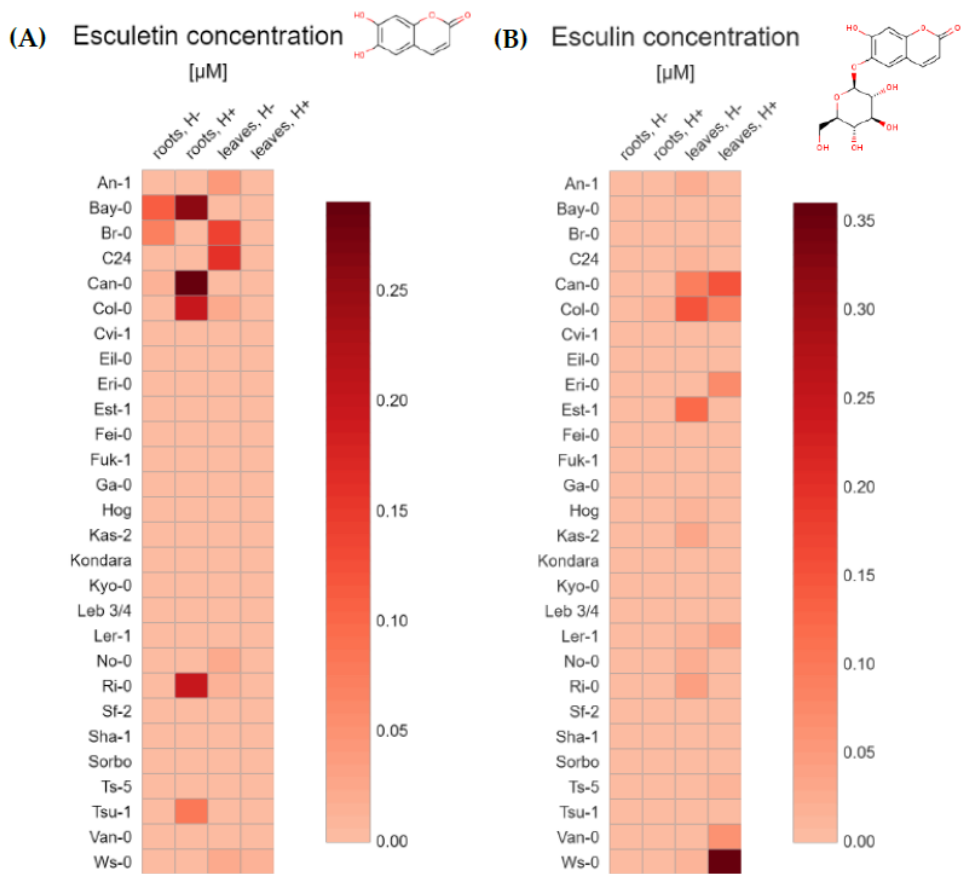
Figure 4. Heat maps based on the average ( A ) esculetin and ( B ) esculin concentration ( µ M/ FW) in Arabidopsis tissue extracts from roots and leaves, without and after hydrolysis. The values used in the plots (https://app.displayr.com (accessed on 20 January 2021)) are the mean of 3 biological replicates. The mean values and standard deviations ( ± SD) are gathered in the supplementary materials (Table S3).